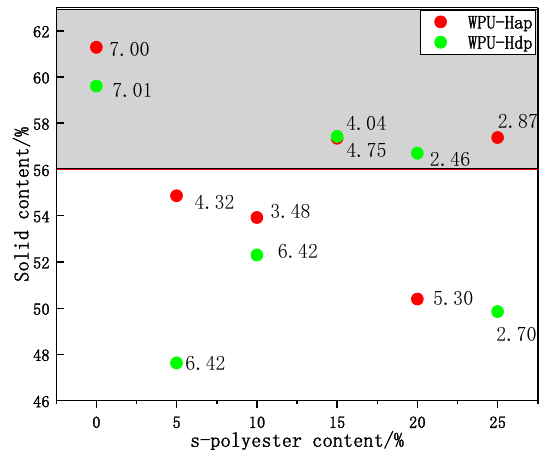
Figure 5. Solid content scatter plot of high solid emulsions.